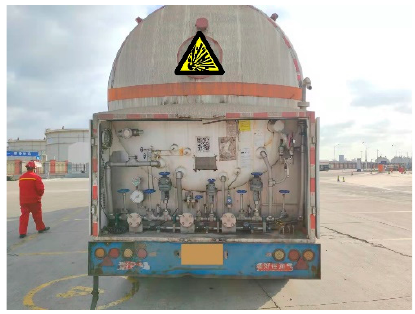
Figure 12. LNG tank car rear.